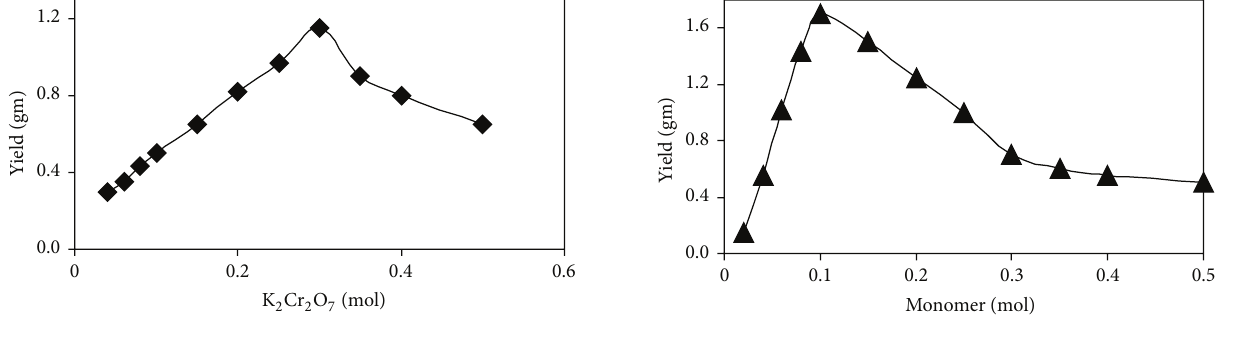
plotted for different oxidant concentrations and the data are graphically represented in Figure 4(a). The initial and overall reaction rates were determined using the following